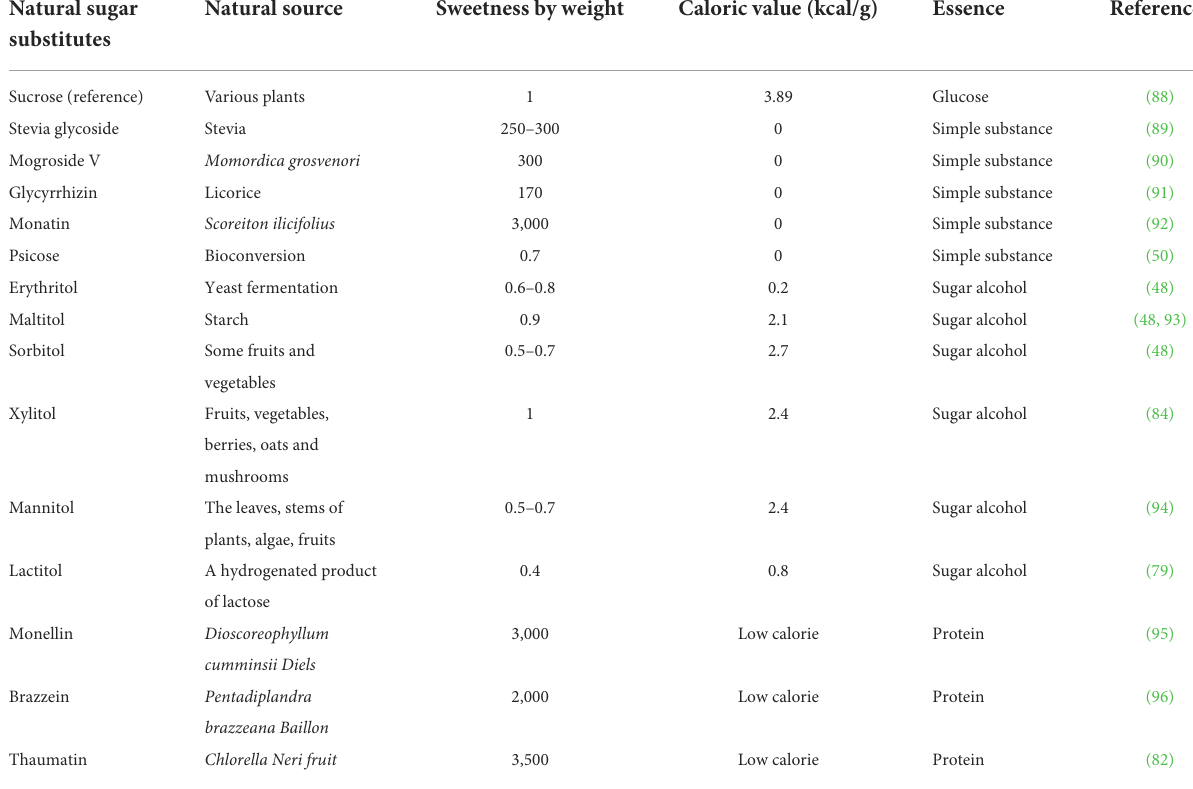
TABLE 2 Source, sweetness, heat and nature of